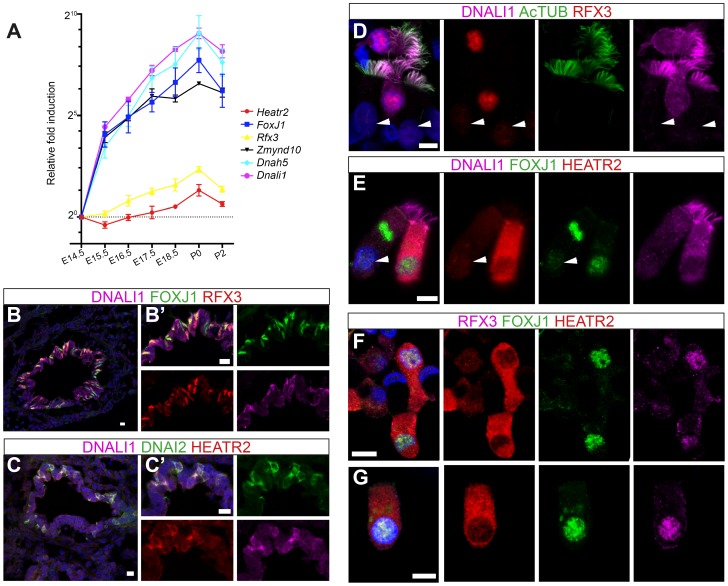
HEATR2 is highly expressed in tissues with motile cilia.(A) Developmental changes in gene expression were assayed by RT-qPCR on RNA extracted from wild-type mouse lungs and trachea from E14.5-P2 (N = 3 independent biological samples for each time-point). qPCR data represents the average of three different assays for three samples performed in triplicate ± SEM. Kruskal-Wallis non-parametric analysis of variance was performed and was significant for all genes (Zmynd10 P = 1.558e−08; Dnahc5 P = 1.141e−05; Dnali1 P = 9.814e−06; Foxj1 P = 1.956e−09; Heatr2 P = 1.604e−06; Rfx3 P = 6.68e−06). (B,C) Immunostaining on sections of E15.5 mouse lungs, where strong RFX3 and FOXJ1 signals are co-expressed in a “salt and pepper” pattern only in large proximal airways, not smaller, more distal airways (see Figure S6A,B). Although they are not yet multiciliated, these cells also express components of axonemal dyneins and high levels of HEATR2 in their cytoplasm. (Scale bar: B,C = 50 µm, B′,C′ = 10 µm). (D–G) Immunostaining of human nasal brush epithelial cells for: (D) RFX3 (HPA: red), acetylated tubulin (green) and DNALI1 (SC: purple); (E) HEATR2 (Novus: red), FOXJ1 (green) and DNALI1 (SC: purple); and (F,G) HEATR2 (Proteintech: red), FOXJ1 (green) and RFX3 (SC: purple). White arrowheads highlight fully mature motile, multiciliated cells (MMCs) that express lower nuclear RFX3 and FOXJ1 with reduced HEATR2 and with axonemal dynein components entirely in cilia. Arrows highlight immature MMCs for comparison. HEATR2 is entirely cytoplasmic at all stages examined (Scale bar: D–G = 10 µm).